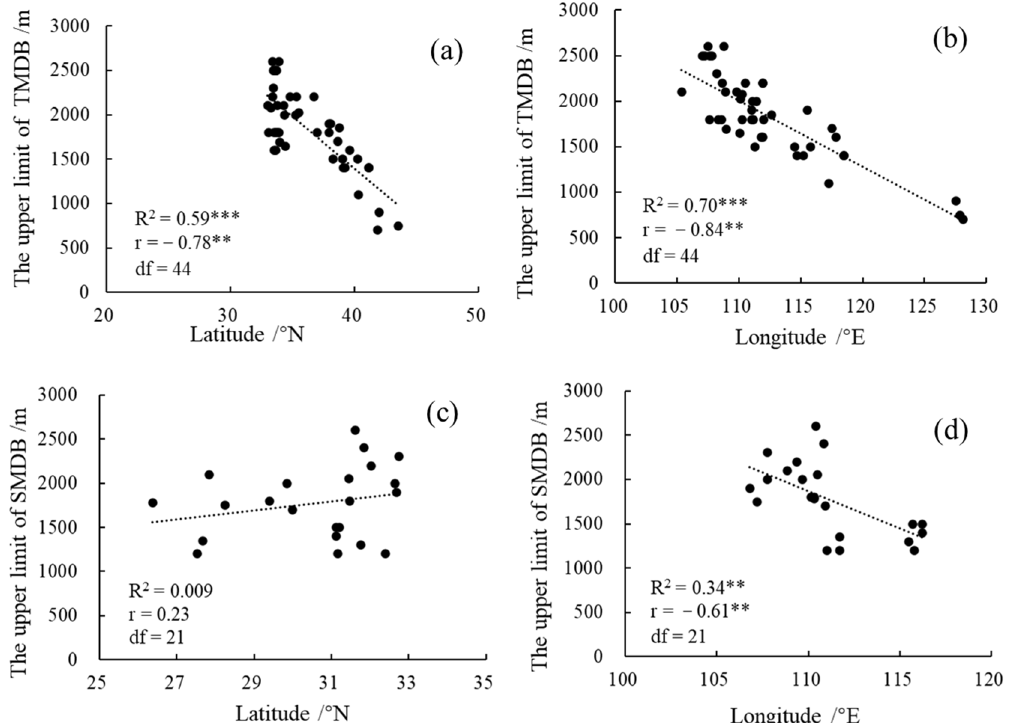
Figure 4. The relationship between the upper limit of MDB and latitude or longitude and the results of regression analysis, ( a , b ) on the temperate mountains without climatic treeline, ( c , d ) on the subtropical mountains without climatic treeline. TMDB, deciduous broad-leaved forest on the temperate mountains without climatic treeline; SMDB, deciduous broad-leaved forest on the subtropical mountains without climatic treeline. “r value” represents Pearson correlation coefficient. df, degree of freedom. Note: ** p <0.01, *** p < 0.001.